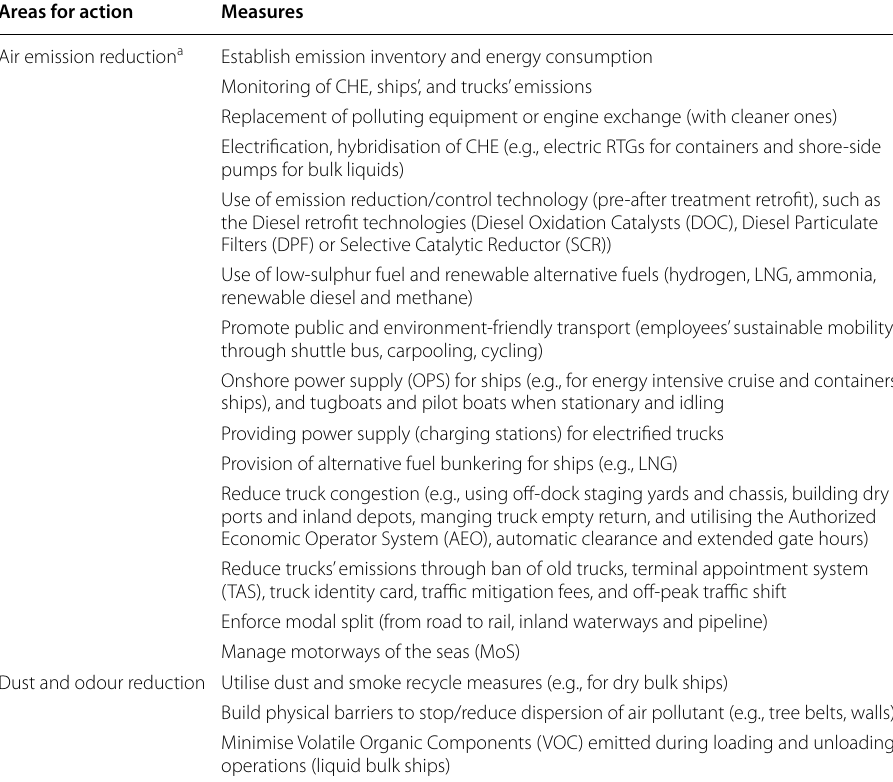
Table 3 Air pollution management actions and measures. Source : Peris-Mora et al. (2005), Darbra et al. (2009), Ng and Song (2010), Dinwoodie et al. (2012), Chang and Wang (2012), I2S2 (2013), Lirn et al. (2013), Shiau and Chuang (2013), PIANC (2014), Acciaro et al. (2014), Roh et al. (2016), IMO (2018b) and Oh et al.